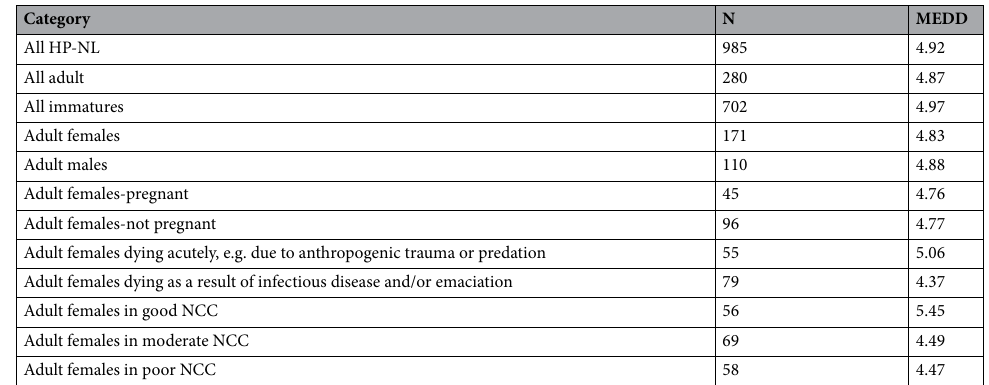
Table 1. Mean energy density of prey constituting porpoise diets (kJ/g) (MEDD) of the full dataset (all harbour porpoises from Dutch waters (new) (All HP-NL)) and for various sub-sets of animals. N-values give the numbers of animals with food remains in their stomachs. NCC = nutritional condition category, based on assessment of blubber thickness, visceral fat and muscle mass during post-mortem